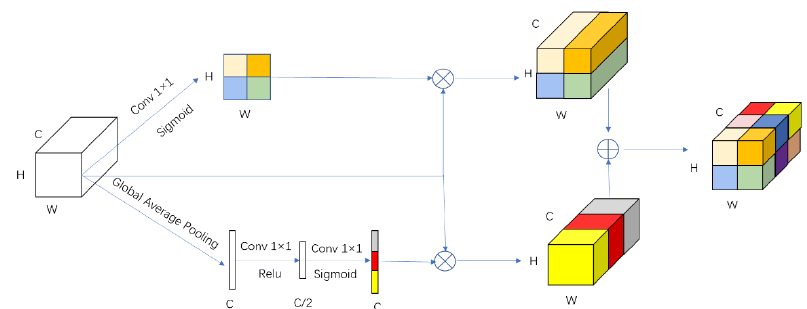
Figure 4. Operation flow of scSE module.